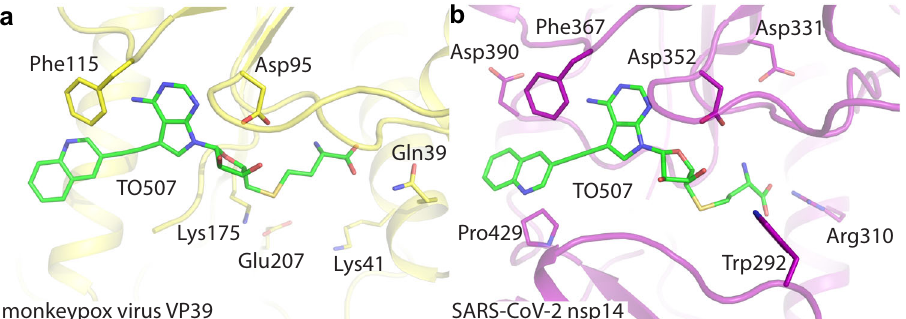
Fig.5|StructuralalignmentoftheMTaseactivesitesofmonkeypoxvirusVP39 with SARS-CoV-2 nsp14. a Inhibitor TO507 in the SAM pocket of VP39. MTase. b Docking model of inhibitor TO507 bound to SARS-CoV-2 nsp14 MTase. Protein backbones are shown in the cartoon representation and depicted in yellow